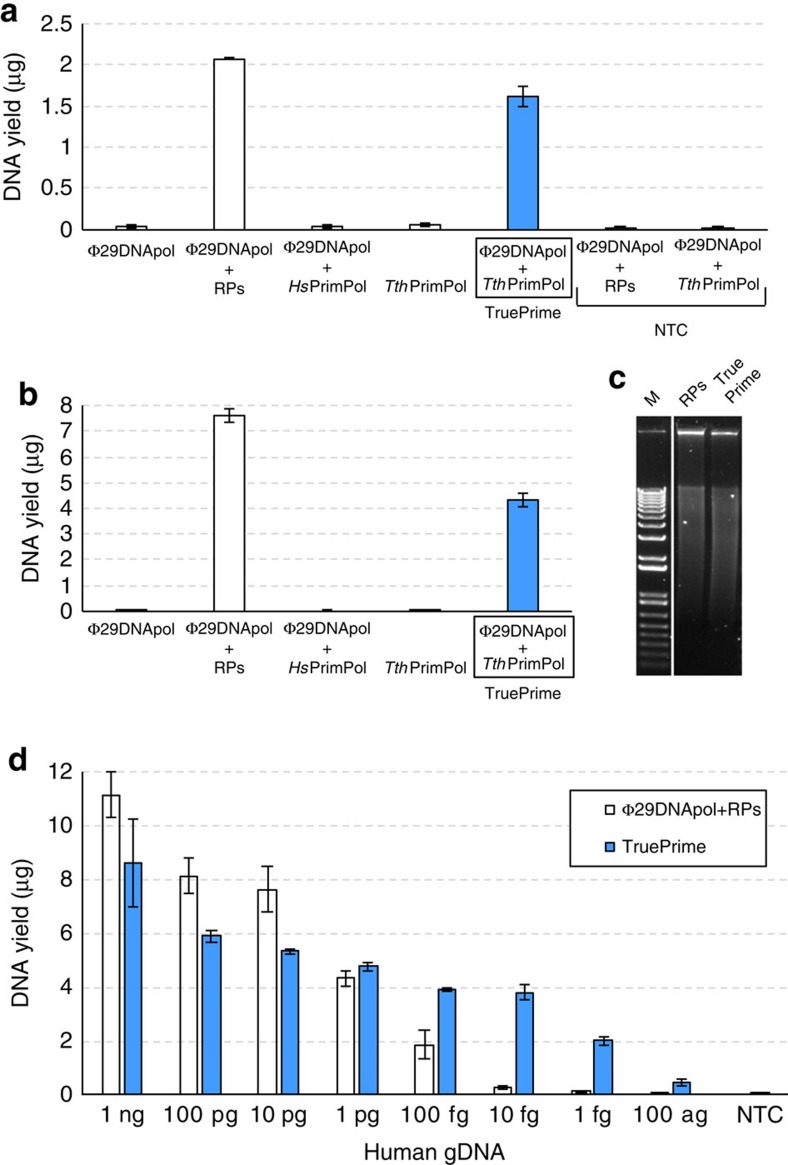
TthPrimPol-mediated MDA (TruePrime) is able to efficiently amplify circular and linear DNA molecules.(a) TthPrimPol can be used instead of RPs to trigger MDA by Φ29DNApol. Combination of both enzymes (TruePrime) is able to proficiently amplify single-stranded M13mp1 circular DNA (100 fg), unlike the combination of Φ29DNApol plus human PrimPol. Individual addition of Φ29DNApol or TthPrimPol does not lead to amplification of input DNA. Non-template controls (NTC) are included, to ensure the lack of background amplification in the absence of input DNA. Error bars are s.d. (b) Amplification of human genomic DNA (6 pg; the equivalent amount contained in a single human cell) by combination of TthPrimPol and Φ29DNApol. HsPrimPol again failed to amplify DNA in cooperation with Φ29DNApol, highlighting the requirements of the specific primase features of TthPrimPol. Error bars are s.d. (c) Agarose gel image showing the similar high size distribution of the amplified fragments obtained with TruePrime versus RPs in part B. (d) Superior sensitivity of TthPrimPol-mediated MDA (TruePrime) for the amplification of human genomic DNA (efficient with a DNA input as low as 1 fg), having about 100-fold higher sensitivity than RP-mediated MDA. Error bars are s.d.